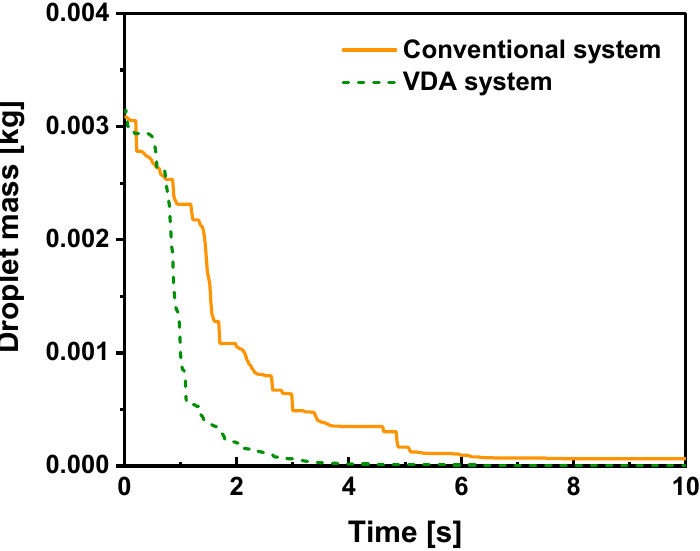
Figure 8. Variation in the droplet mass in the conventional and VDA systems according to the time after coughing.